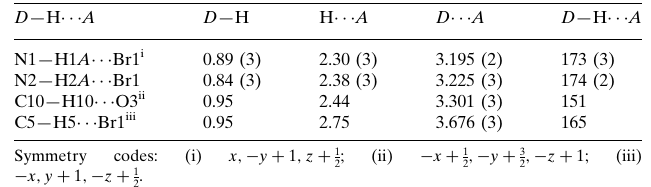
Hydrogen-bond geometry (A˚ , (cid:3)